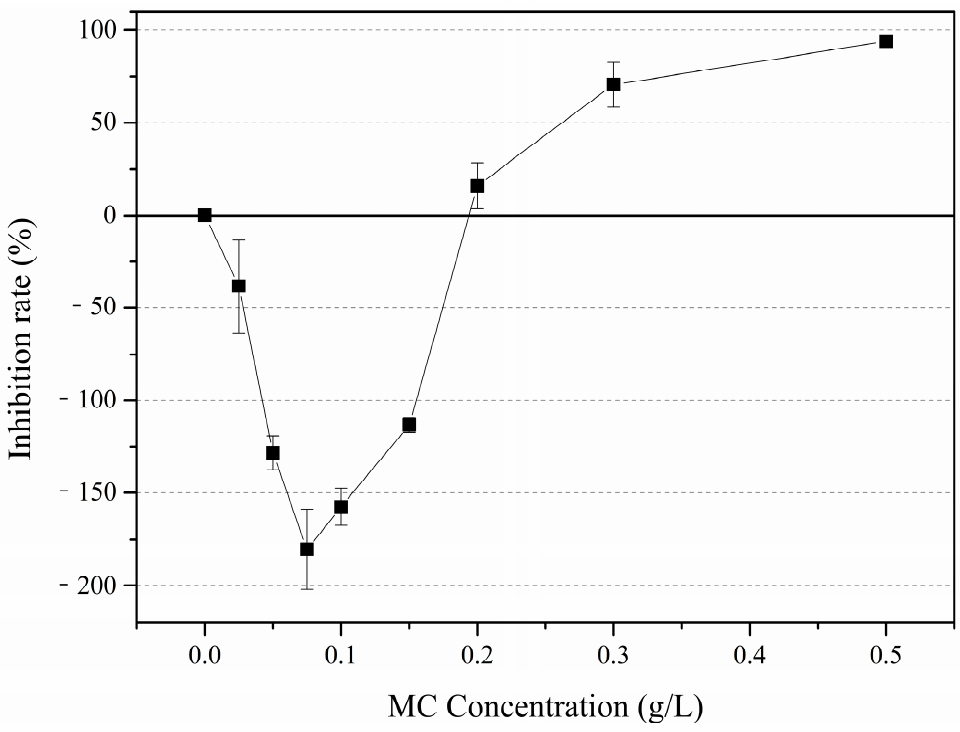
Figure 4. Inhibition rates of P. globosa colony formation on the 10th day under different MC